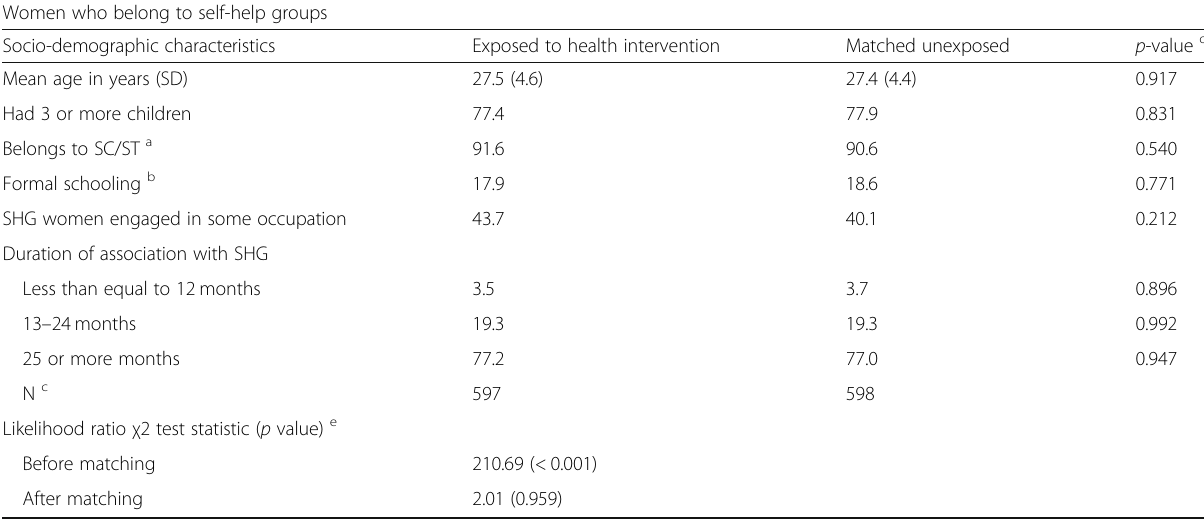
were exposed, Bihar, India,